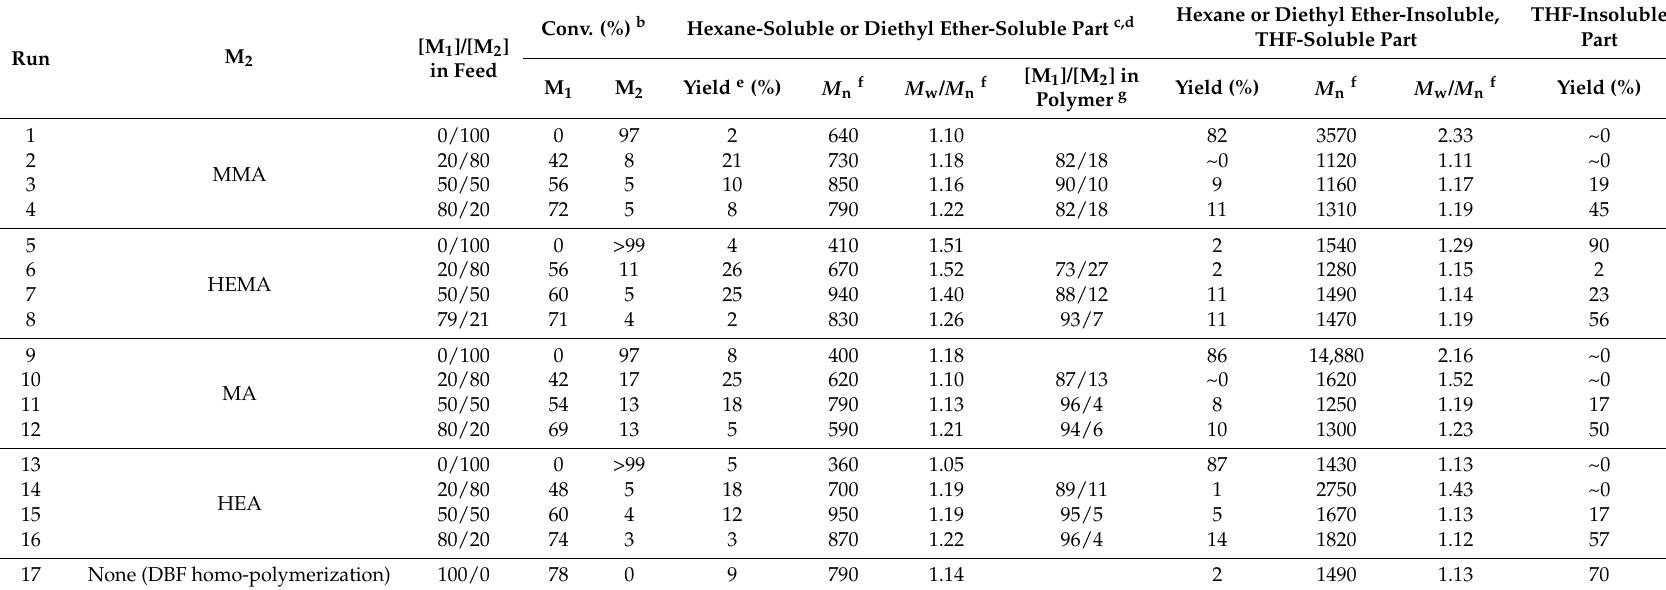
Table 1. Radical copolymerization of DBF (M 1 ) and methacrylates and acrylates (M 2 ) in toluene at 60 ◦ C for 24 h using AIBN a